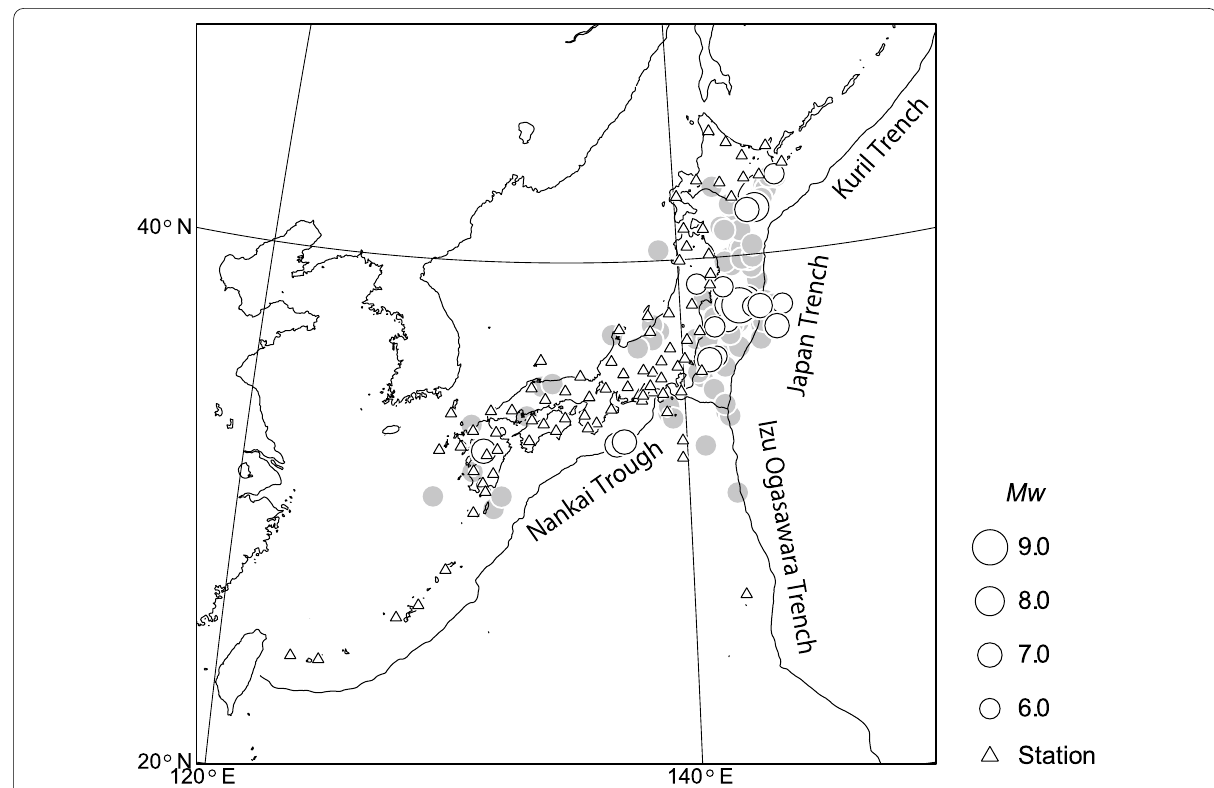
Fig. 1 Map showing the locations of the stations (triangles) and epicenters (open circles) of the earthquakes used to obtain the regression relationship between earthquake magnitude and observed peak amplitudes. Open and gray-filled circles denote the events used for Figs. 5 and